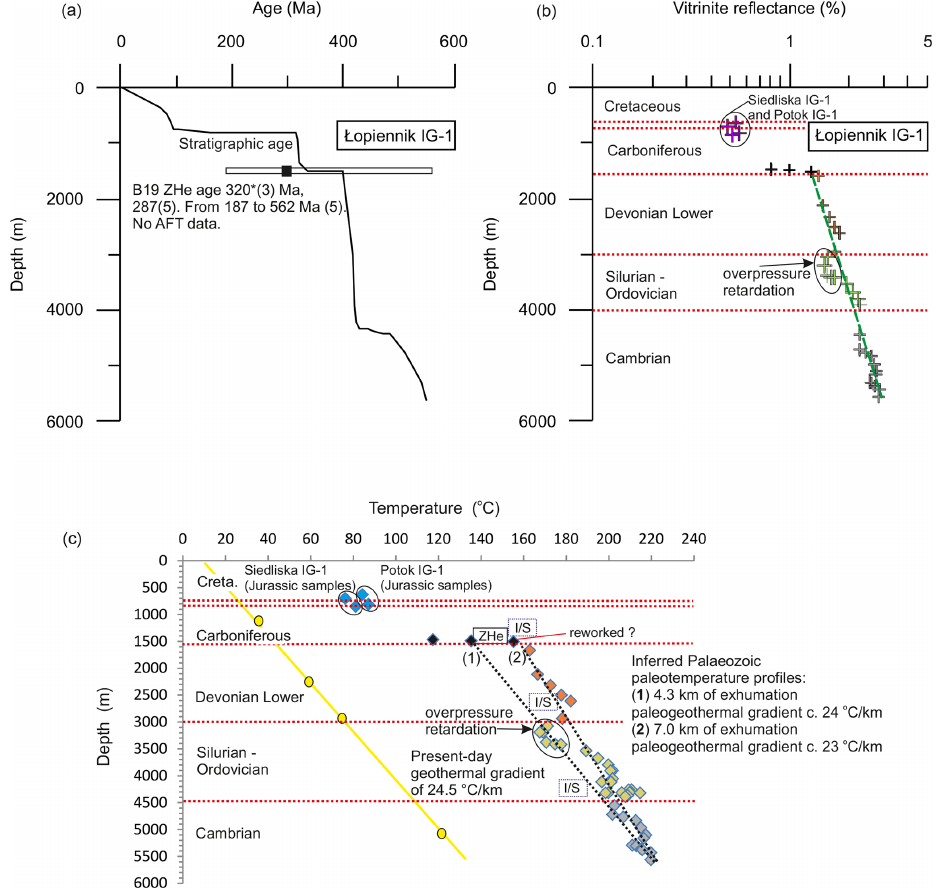
Figure 11. Łopiennik IG-1 borehole data (Lublin Basin). (a) Thermochronological data vs. stratigraphic age, (b) VR profile, (c) paleotemper- ature profile. Mesozoic VR data from the Siedliska IG-1 and Potok IG-1 boreholes are from the Middle–Upper Jurassic sediments (sampling depth is not to scale). Carboniferous VR data change rapidly in a short profile section, and different VR and paleogeothermal gradients can be established. Other explanations are as in Figs. 6 and